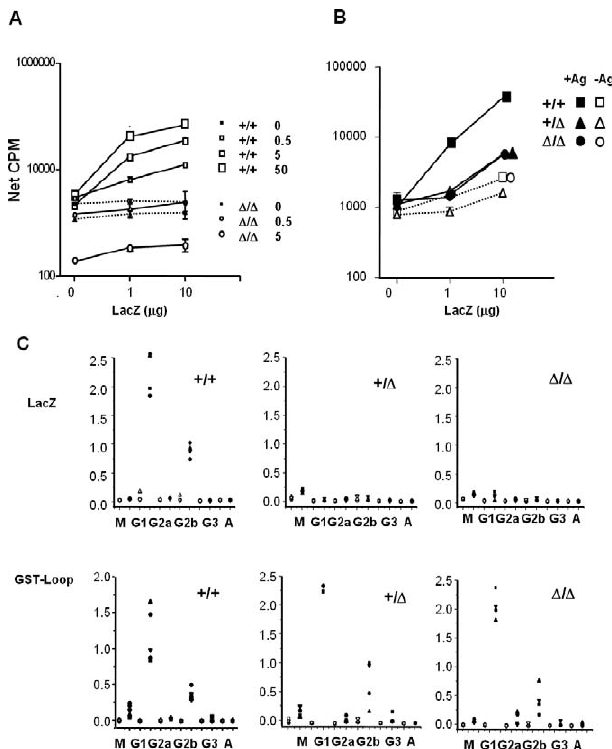
Figure 4. CD4 þ Tolerance to LacZ in the TDLacZ Mouse (A) CD4 þ T cells of mice immunized with 0, 0.5, 5, or 50 l g of LacZ, were stimulated with 0, 1, or 10 l g/ml of LacZ. The responses of LacZ immunized mice in solid lines with open symbols, the adjuvant immunized mice in dotted lines with closed symbols. Rectangles indicate þ / þ , and ovals D / D . (B) The T cells response of þ / þ (rectangles), D / þ (triangles), and D / D (ovals) immunization with (solid lines and closed symbols) or without (dotted lines and open symbols) 25 l g of LacZ. There were no significant differences in the recovery of cell numbers from the immunized mice of any genotypes. (C) Antibody isotype profiles of þ / þ , þ / D , and D / D mice immunized with LacZ (upper panels) or the GST-TSCOT-Loop (lower panels). The OD reading of individual serum is shown as a single symbol. Open symbols are for preimmune serum, and filled symbols are for immunized serum. IgM (M), IgG1 (G1) IgG2a (G2a), IgG2b (G2b), IgG3 (G3), and IgA (A) levels are